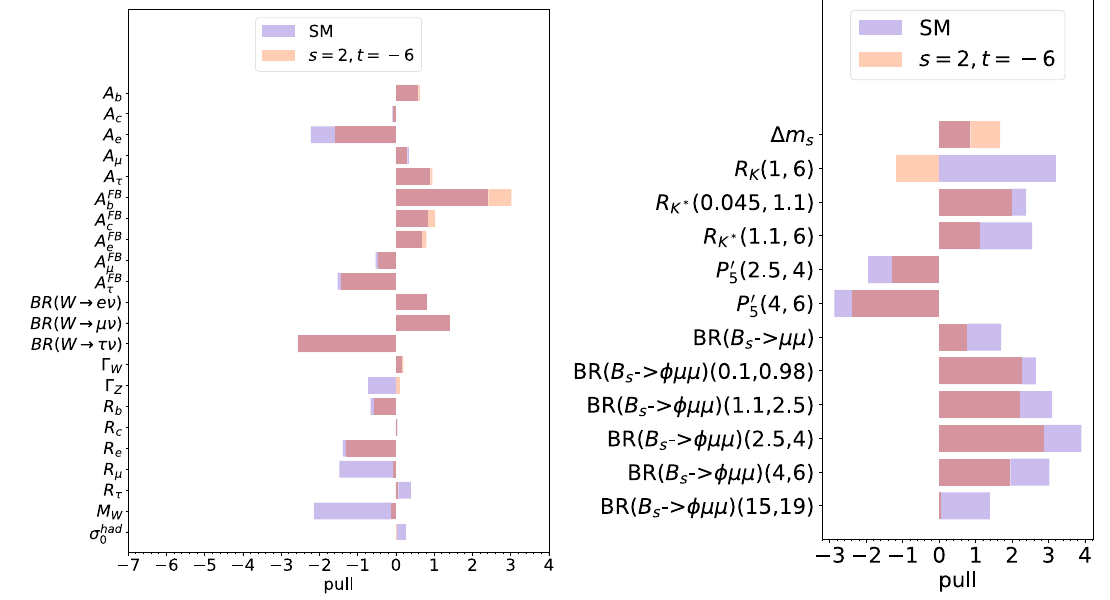
Fig. 3 Pulls of interest for the default smelli2.3.2 constraint on M W (i.e. excluding the recent CDF measurement) and n = 3 as in (4.13). In the left-hand panel, we display the EWPOs, whereas in the right-hand panel, we display selected observables of interest to b → sl + l −